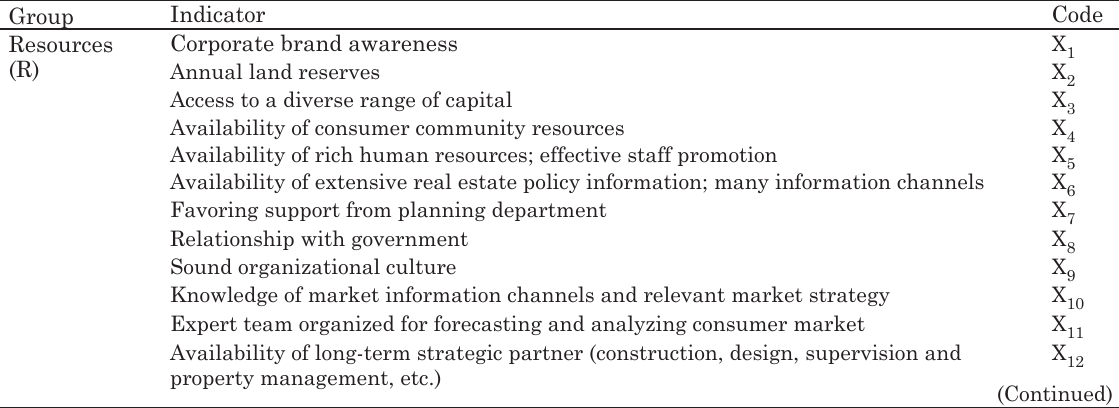
table 1. a list of competitiveness indicators for the real estate developers in China Group